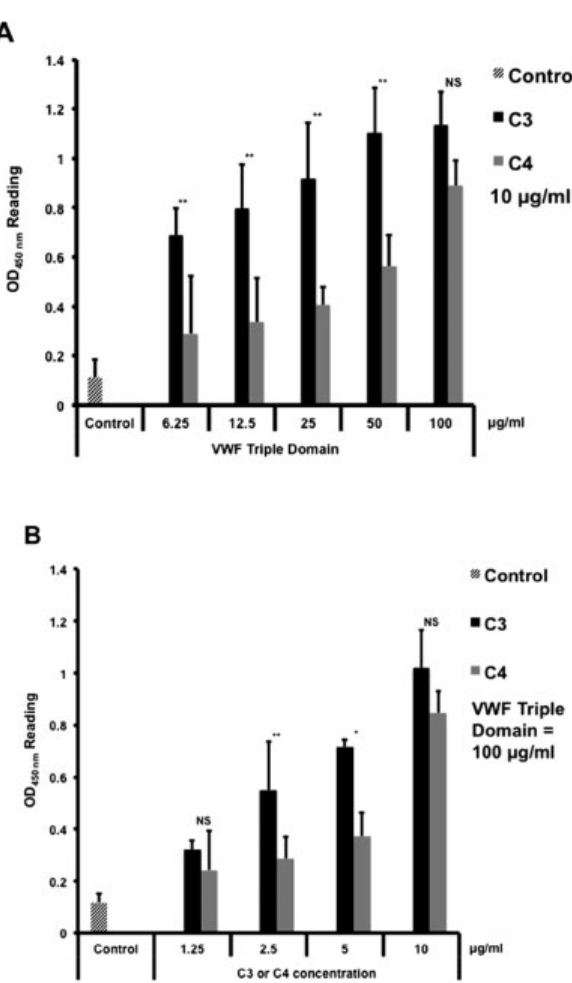
Fig. 2 Recombinant VWF-A1A2A3 triple domain binds to puri fi ed C3 and, to a lesser extent, puri fi ed C4. In preliminary experiments using one immobilized protein and one soluble protein, we determined the concentration ratios that yielded maximum binding. In ( A ), a constant concentration of either C3 ( n ¼ 5) or C4 ( n ¼ 5) was premixed with a range of VWFA1A2A3 triple domain concentrations before incubation in microwells with immobilized mouse monoclonal anti-His-antibody (160 ng/mL) to capture the His-tagged VWF A1A2A3. Subsequently, C3 or C4 bound to the VWF A1A2A3 was detected using goat anti- human C3 or goat anti-human C4 plus rabbit anti-goat HRP- tagged secondary antibody and TMB. Our rabbit anti-human VWF does not recognize the VWFA1 domain (see ► Fig.1 ); consequently, to